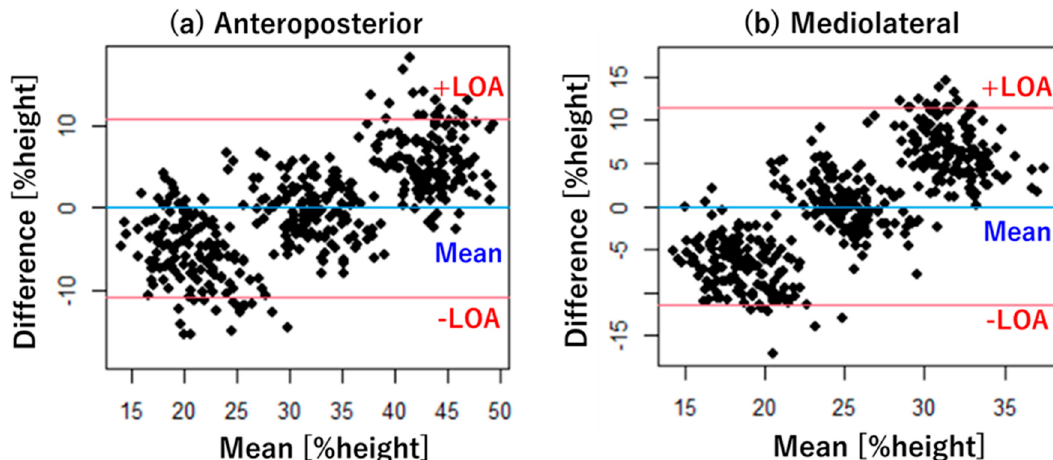
Table 9. Statistical results.